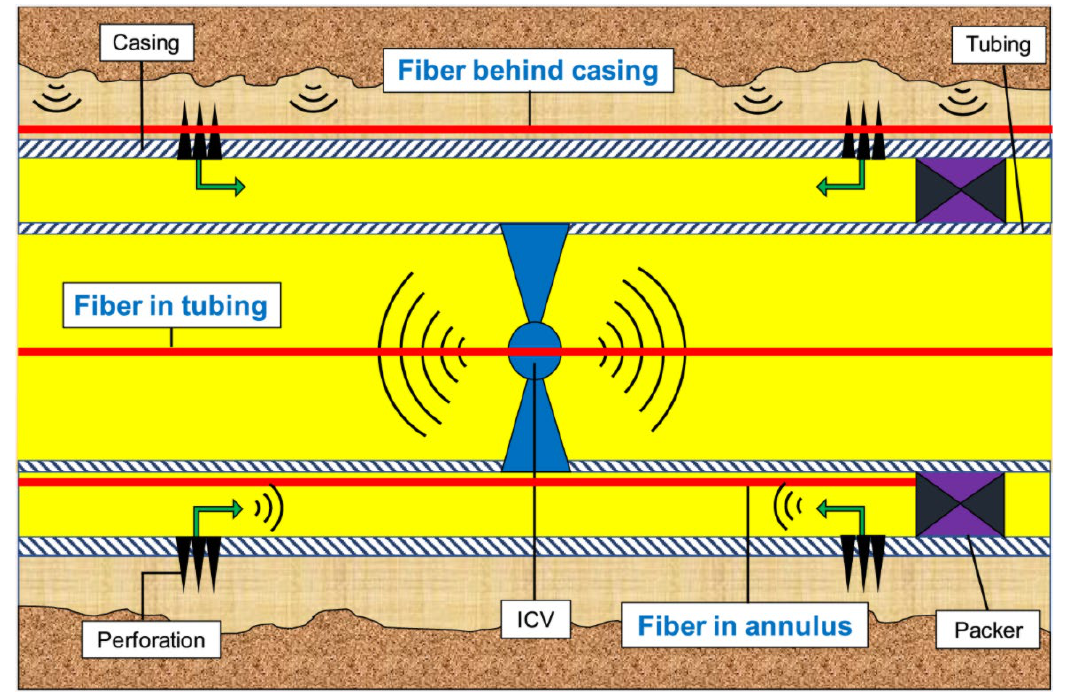
Figure 4. Distributed fiber optic sensing installation in the wellbore [12]. Table 1. Advantages and disadvantages of different installation positions of optical fiber.